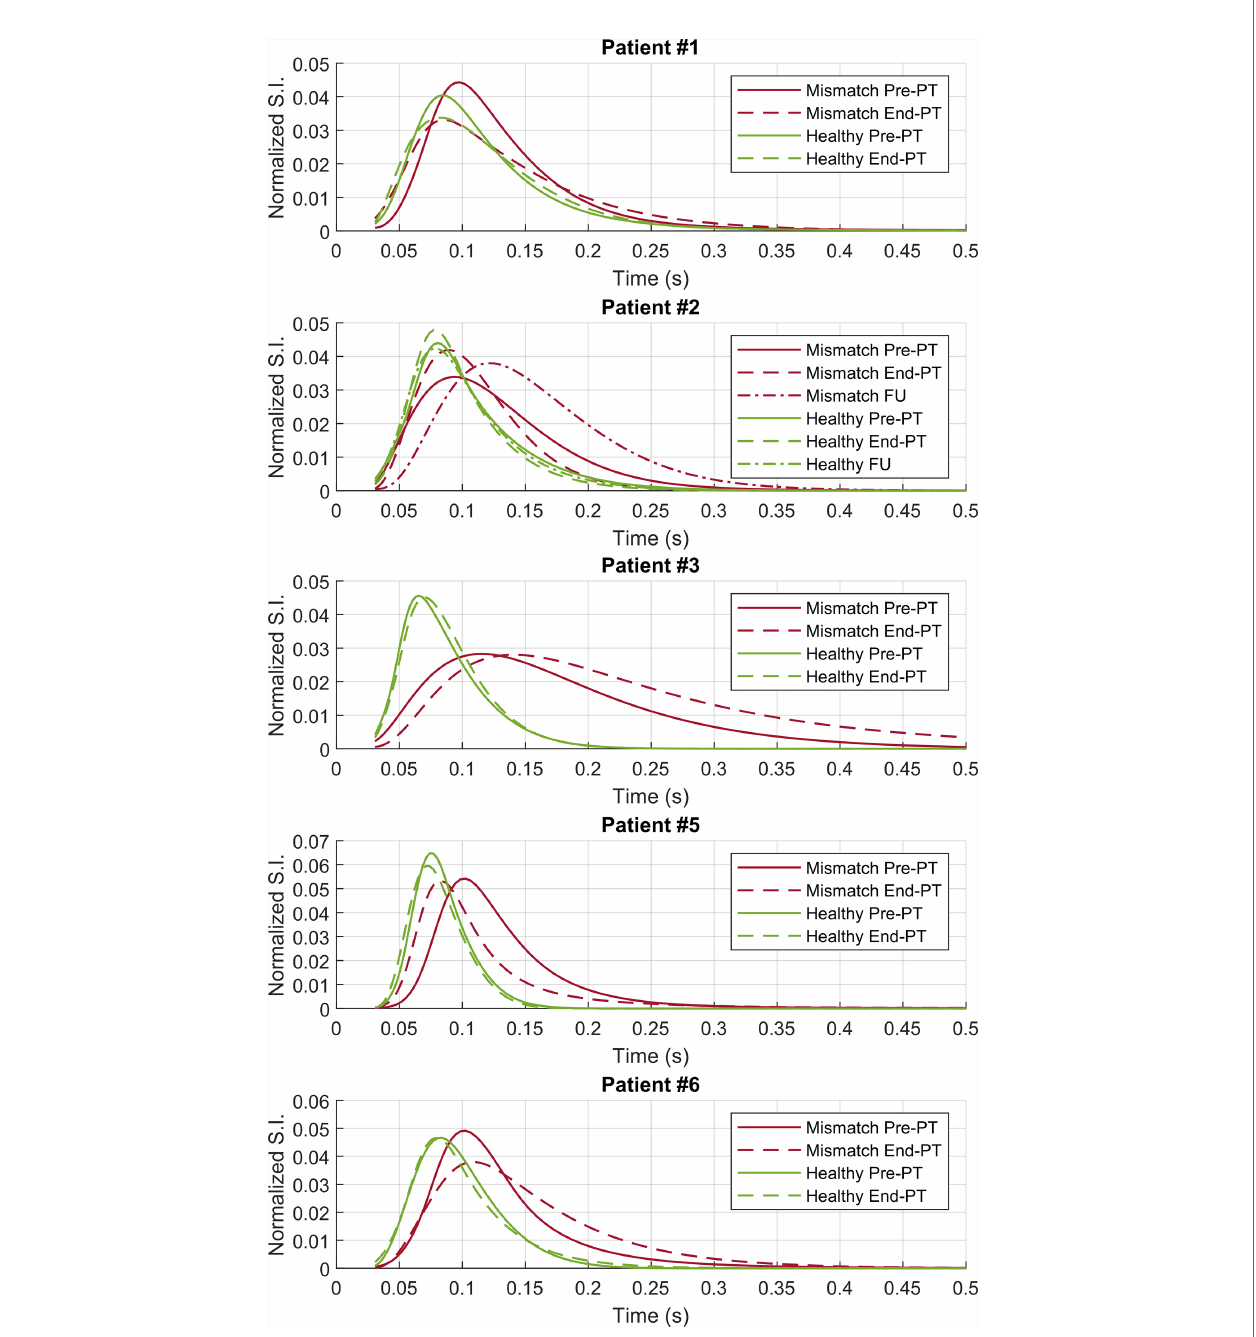
FIGURE 4 | ROI analysis — T2 distributions on the contralateral healthy (green lines) and on the mismatch (red lines) ROIs for patients #1 – 3 and #5 – 6. Pre-PT (continuous lines) and end-PT (dashed lines) T2 distributions are shown. For patient #2 also the follow-up T2 distributions (dotted lines) are